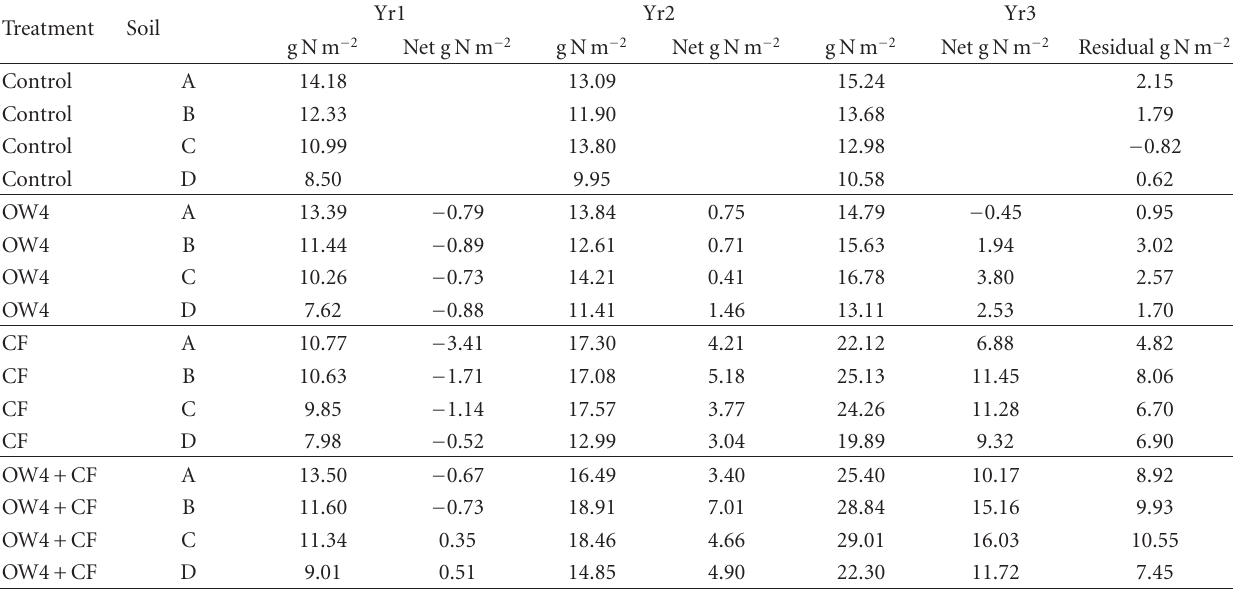
Table 6: Yearly plant N-uptake, net plant N-uptake (plant N-uptake (applied organic matter)-plant N-uptake (control)), and the